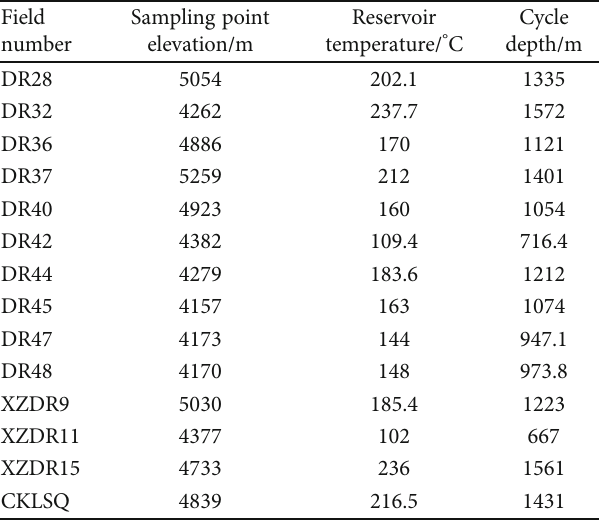
Table 10: Calculation of underground hot water circulation depth in in the study